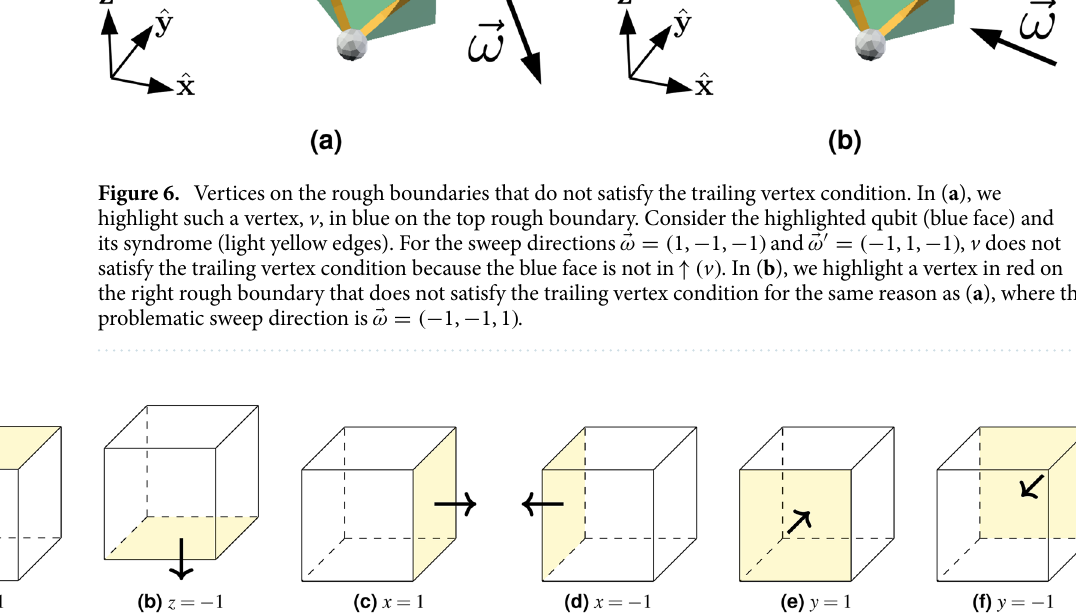
Figure 7. The constraints on the sweep directions � ω = ( x , y , z ) ∈ { ( ± 1, ± 1, ± 1 ) } such that all vertices on the highlighted boundary satisfy the trailing vertex